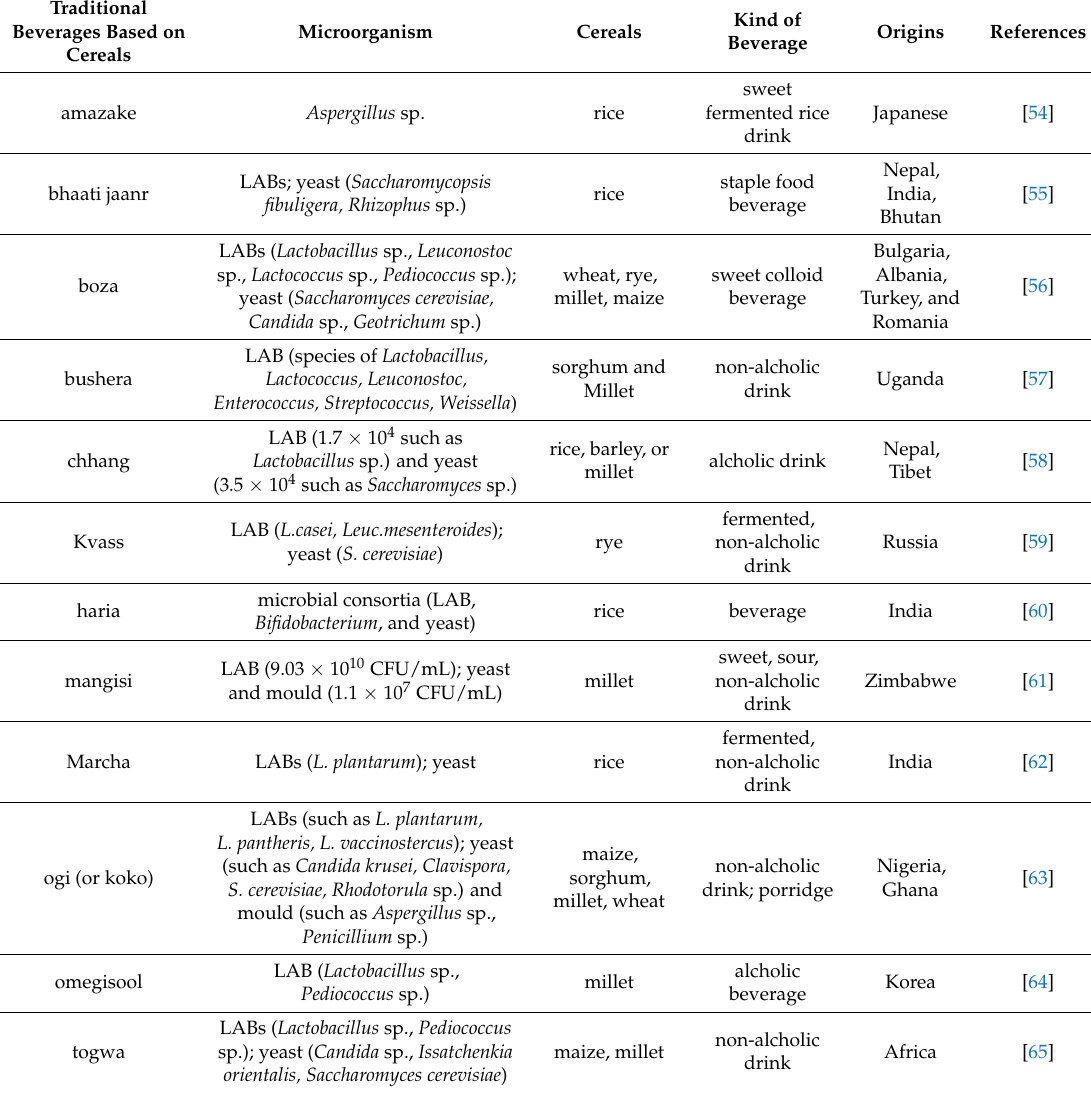
Table 1. Traditional cereal-based